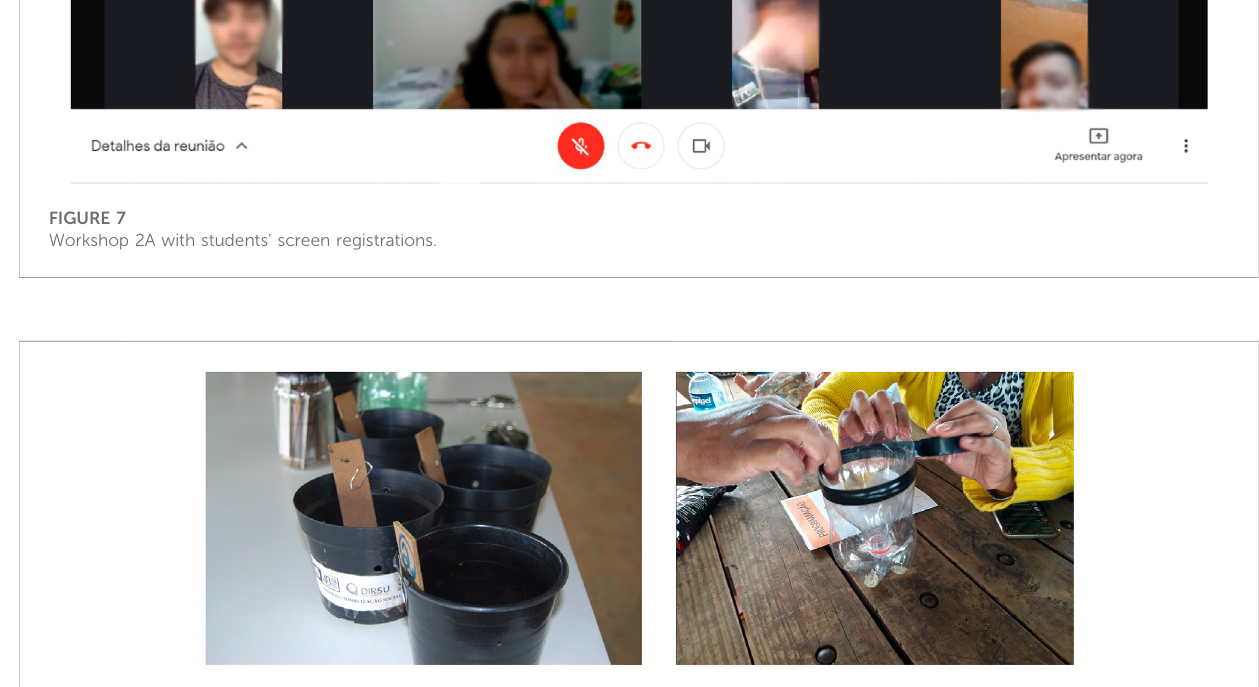
FIGURE 8 Egg traps and adult mosquito traps used in the